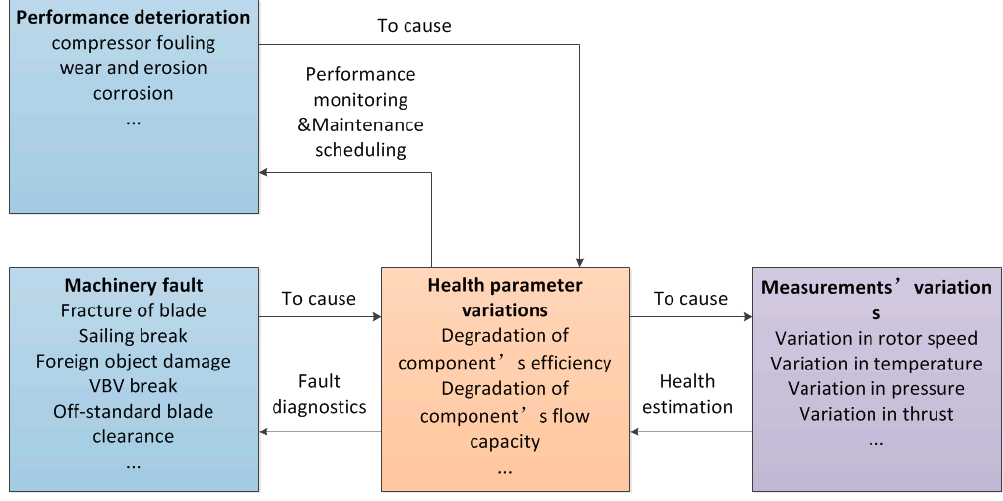
Figure 2. Schematic of relationships in the GPHM.